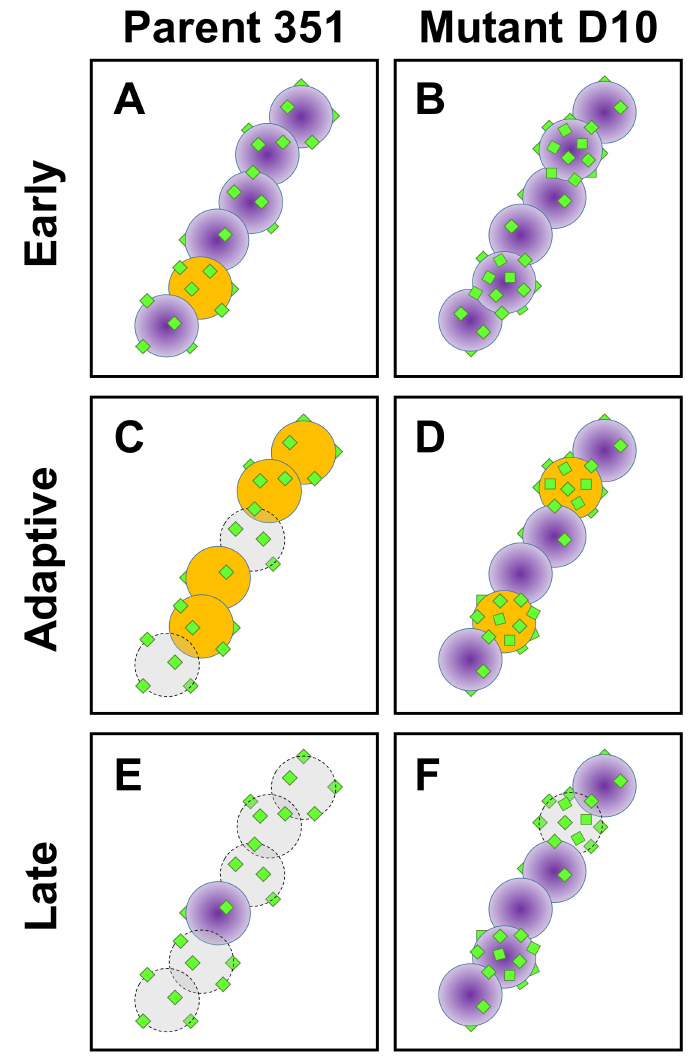
Figure 4. Integrative model of DAP-S vs. DAP-R phenotypes in S. mitis-oralis based on our current and prior data. ( A – F ) Comparative responses to and outcomes of DAP exposure at different time points in parent and mutant study strains 351 and D10. Early post-DAP exposure, parent 351 ( A ) cells accumulate DAP equivalently and early hyper-polarization is initiated. In contrast, specific cells in DAP-R mutant D10 chains hyper-accumulate DAP ( B ), with minimal to no hyper-polarization. Adaptive responses to restore normal cell membrane energetics fail in parent 351, resulting in hyper-polarization and initial cell death ( C ). By comparison, only specific cells within mutant D10 streptococcal chains appear to hyperpolarize, protecting the remaining population ( D ). Ongoing inability to compensate leads to significant cell death in parent 351 ( E ), whereas mutant D10 organisms have substantially greater survival ( F ). Key: DAP = green squares; viable S. mitis-oralis cells = purple; hyperpolarized S. mitis-oralis cells = gold; killed S. mitis-oralis cells =